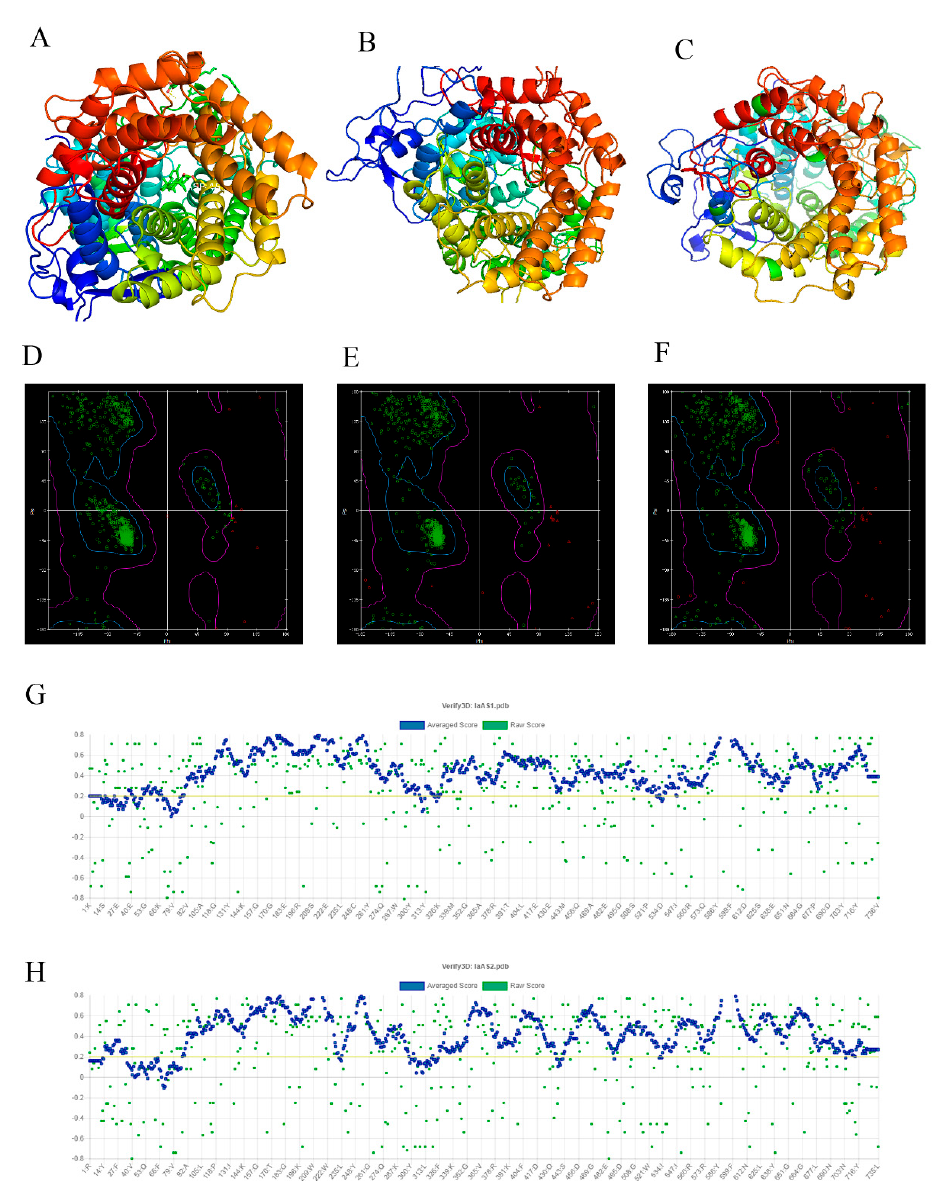
Figure 1. Homology modeling and evaluation of IaAS1 and IaAS2 structures. The Ribbon diagrams and Ramachandran plots for the template ( A , D ), IaAS1 ( B , E ) and IaAS2 ( C , F ), respectively. The 3D-1D compatibility of IaAS1 ( G ) and IaAS2 ( H ) structures evaluated by Verify 3D.